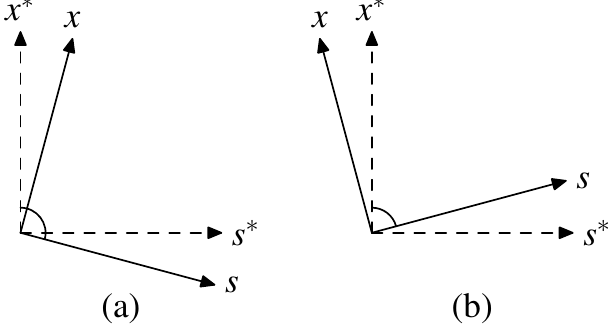
FIG. 3. Sign of the half crossing angle in M minus if the angle between the two axes s and x (cid:17) is larger than 90 (cid:18) , which is shown in (a). The sign is plus if the angle between the two axes s and x (cid:17) is less than 90 (cid:18) , which is shown in (b).